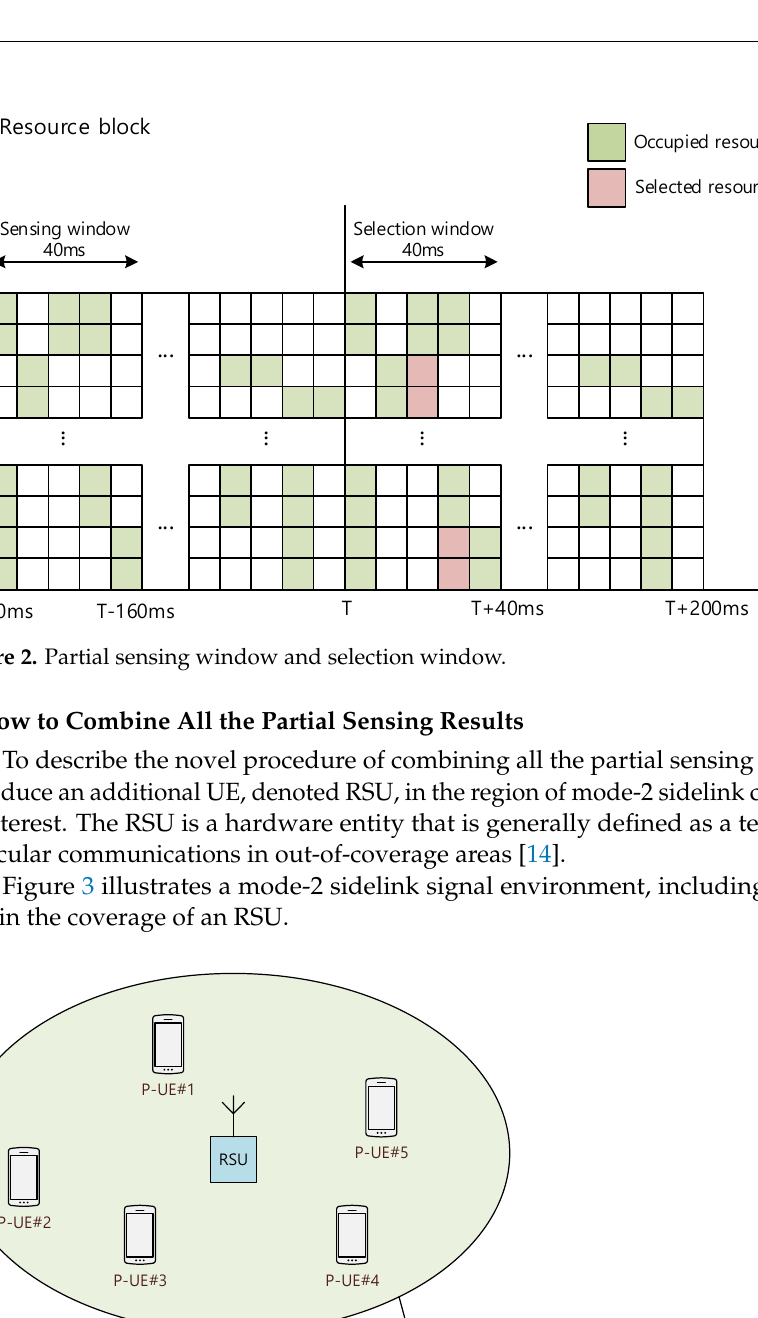
Figure 2. Partial sensing window and selection window.